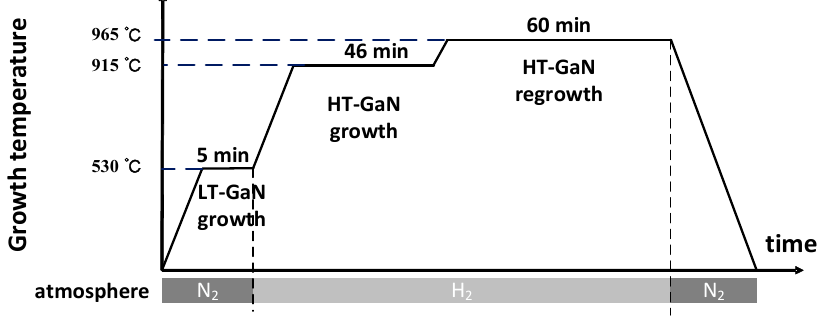
Figure 9. Procedure of HT-GaN regrowth method.